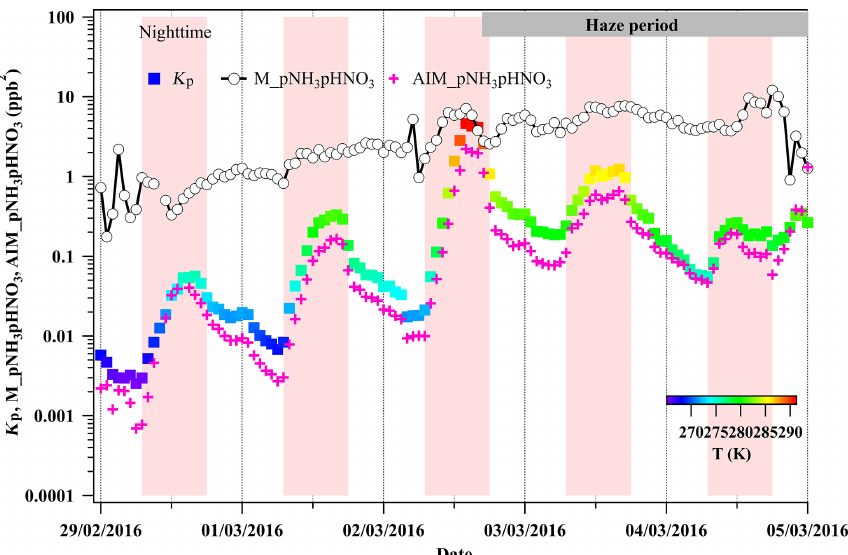
Figure 3. The comparison of the calculated temperature-dependent dissociation constant of NH 4 NO 3 ( K p ; Seinfeld and Pandis, 2006) in the absence of liquid water, the product of the equilibrium vapor pressure of gaseous NH 3 and HNO 3 from E-AIM (AIM_pNH 3 pHNO 3 ), and the product of mixing ratios of gaseous NH 3 and HNO 3 measured by GAC–IC (M_pNH 3 pHNO 3 ). Here, K p is colored by the ambient temperature ranging 265–293K during 29 February to 5 March 2016.